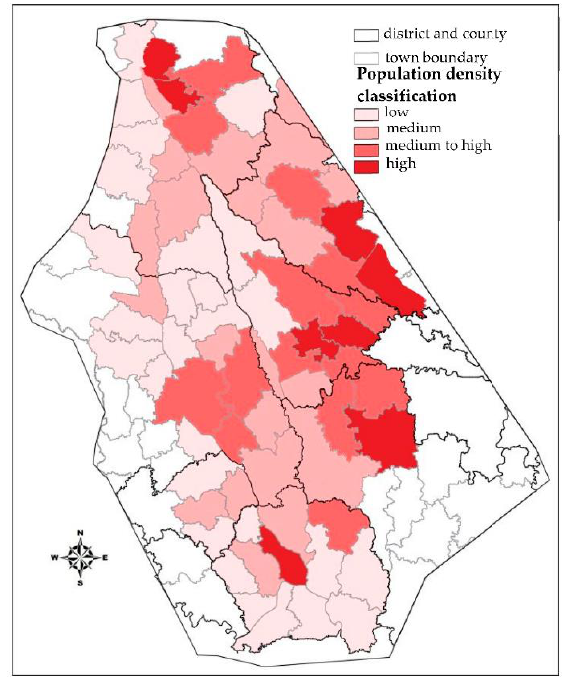
Figure 7. Population density of each unit.